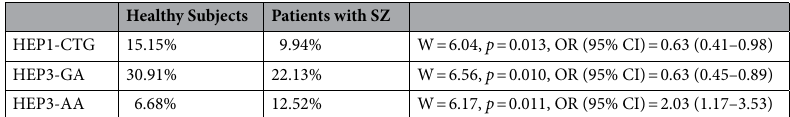
Table 1. Haplotypic association results. Only those haplotypes showing significant frequency differences between healthy subjects (n = 138) and patients with SZ (n = 238) are reported in this table. The haplotype allelic combinations and the corresponding frequencies are shown for each group, as well as the logistic regression statistic (Wald, W), the p value (obtained after applying 10,000 permutations procedure) and the odds ratio (OR) and its 95% confidence interval (95%